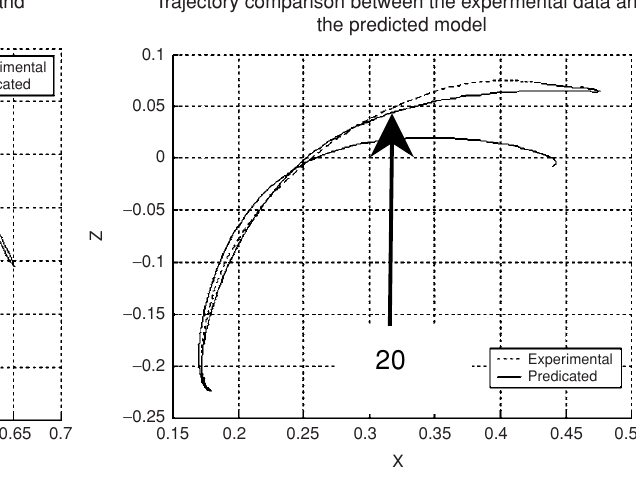
Figure 9 Simulated trajectory. (a) Wrist. (b) Elbow. The mean error value of the wrist position is equal